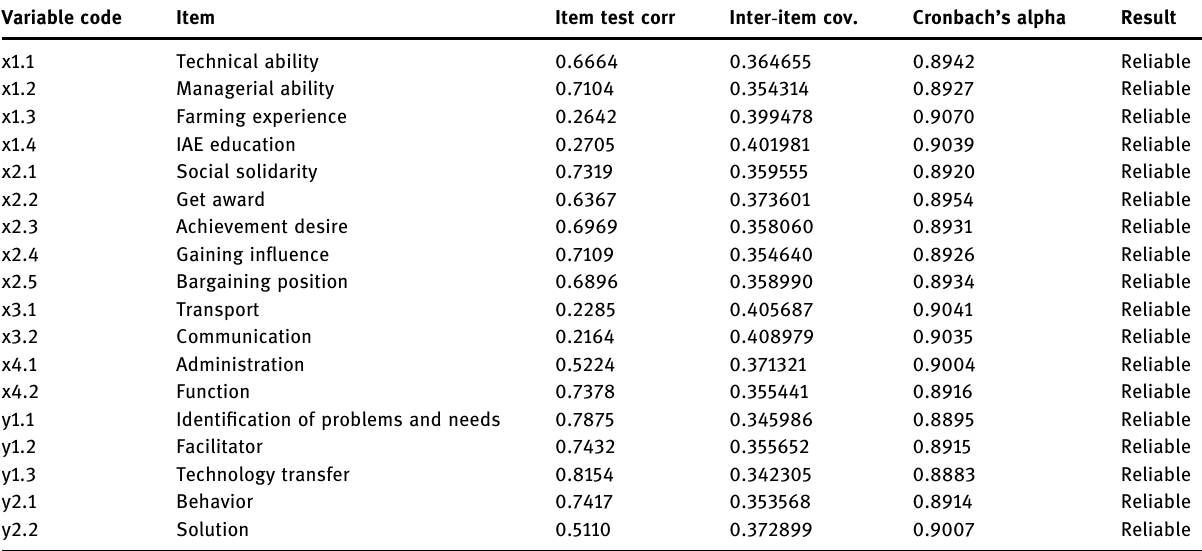
Table 4: The results of the reliability test on the variable Variable